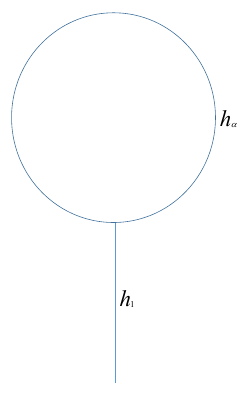
Figure 2 . 1-point block on